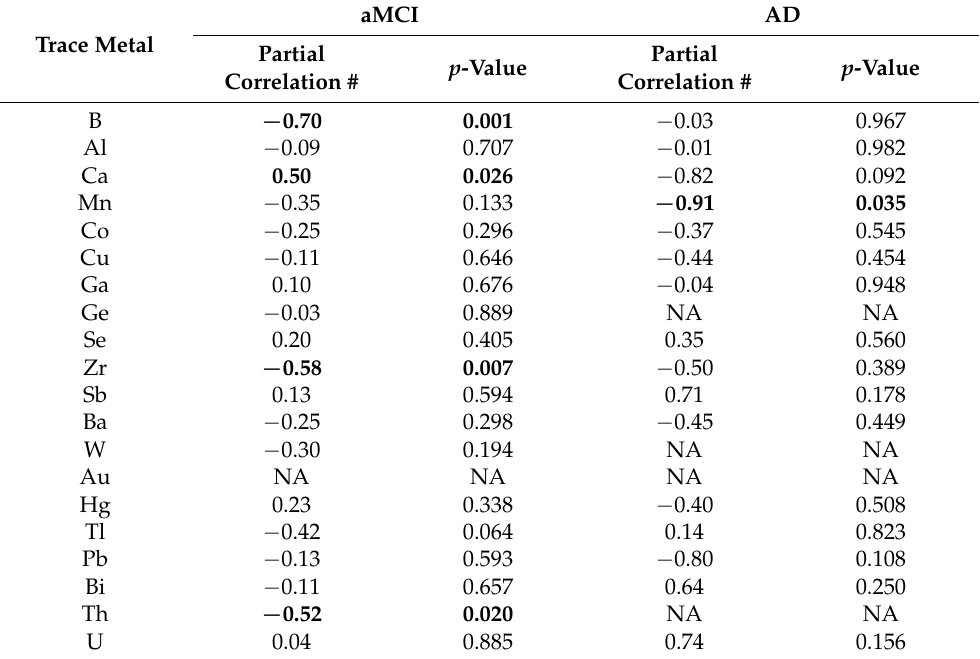
Table 3. Association between trace metals and annual change of MMSE